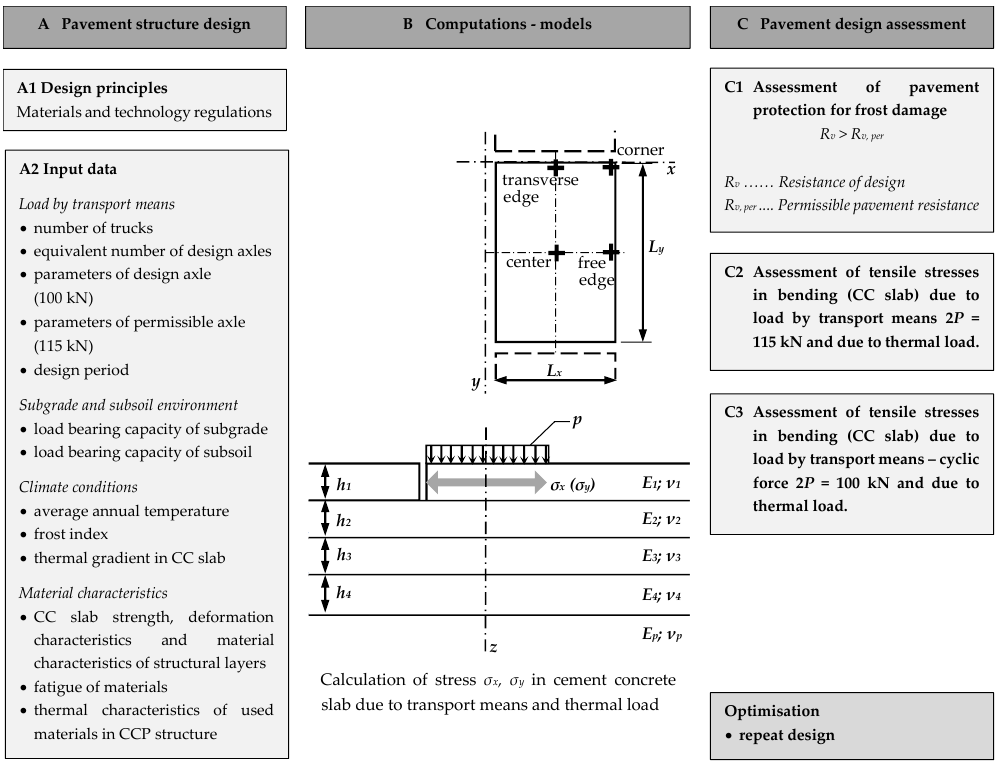
Figure 8. Design process of CCP according to TP 098. Reprinted with permission from [45]. Copyright 2022 by the Slovak Road Administration.